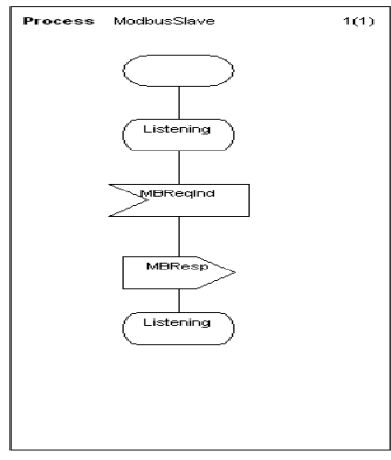
Figure 10:ModbusSlave Process